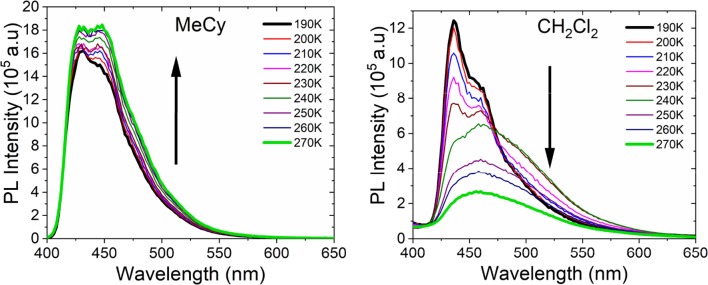
Emission spectra of AuBZI in MeCy and CH2Cl2 at various temperatures.